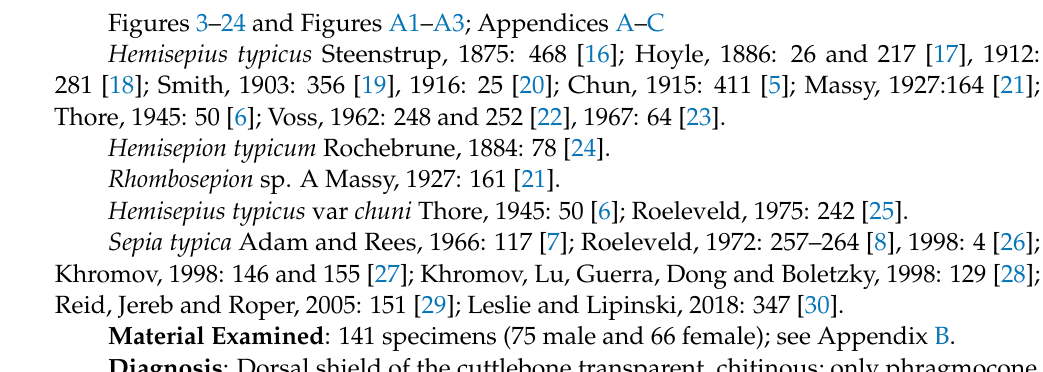
Figure 6. Variation in the ventral mantle in Sepia typica , especially the degree of emargination in the anterior margin and in the size and shape of the ventro-marginal row of glands and pores: from left